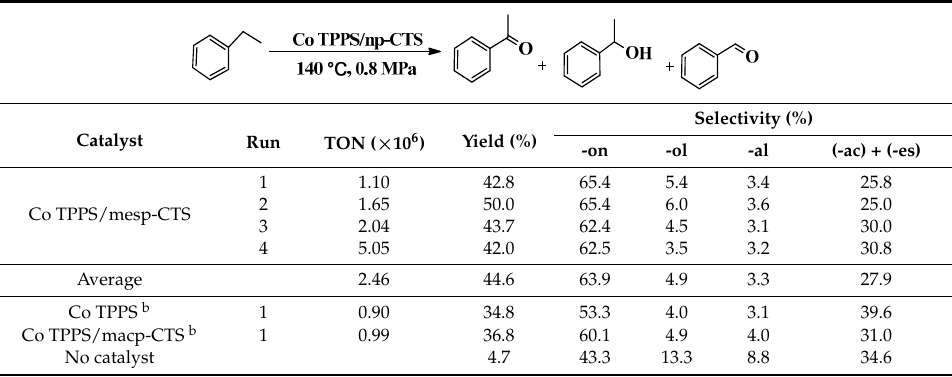
Table 3. Comparison of the catalytic performance of Co TPPS/mesp-CTSwith that of CoTPPS/macroporous-CTS(macp-CTS) and Co TPPS. a